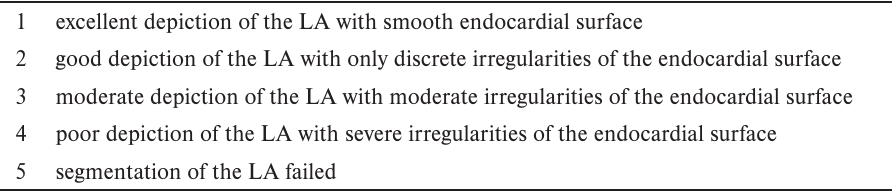
Table 2. Visual data quality on 5-point scale.